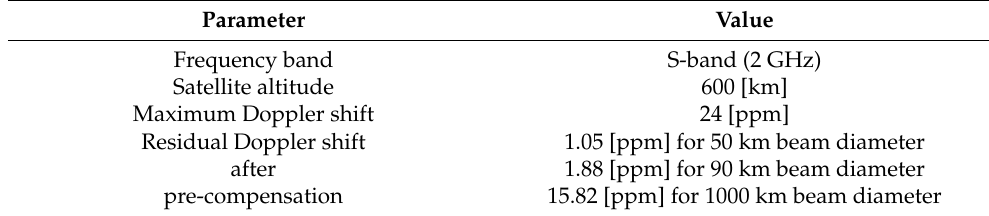
Table 1. Maximum Doppler shift and the residual Doppler shift after